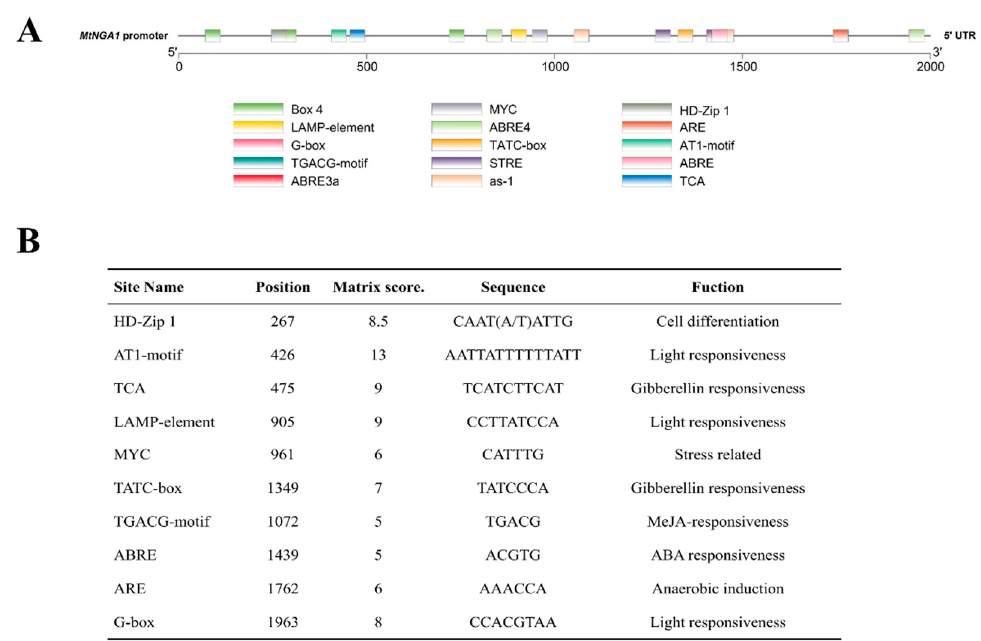
Figure 3. Promoter analysis of MtNGA1 gene ( A ) Cis acting elements contained in MtNGA1 gene promoterand. ( B ) Prediction of binding sites for the transcription factors in the MtNGA1 gene promoter.